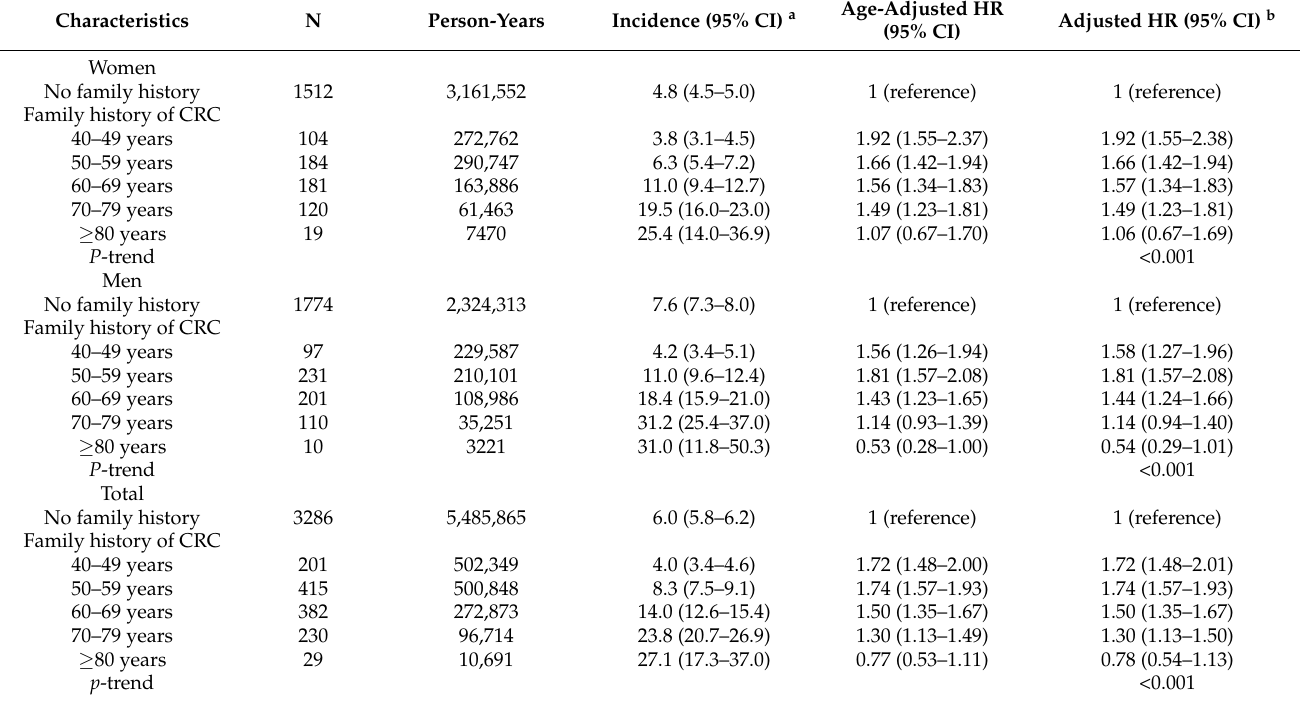
Table 4. Age-specific relative risk of CRC among individuals with a family history of